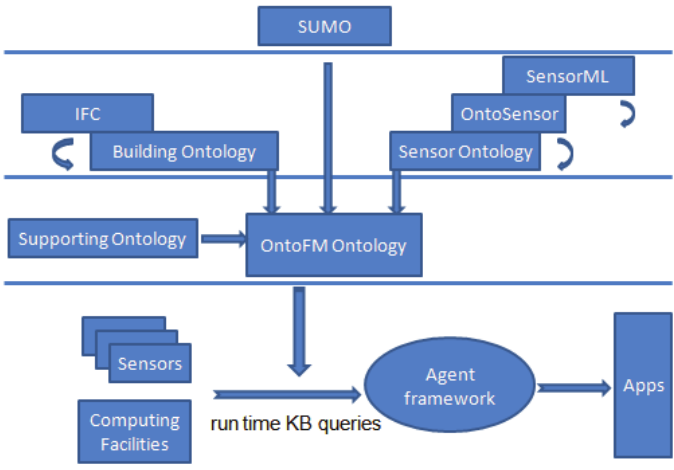
Fig. 2. OntoFM ontology development